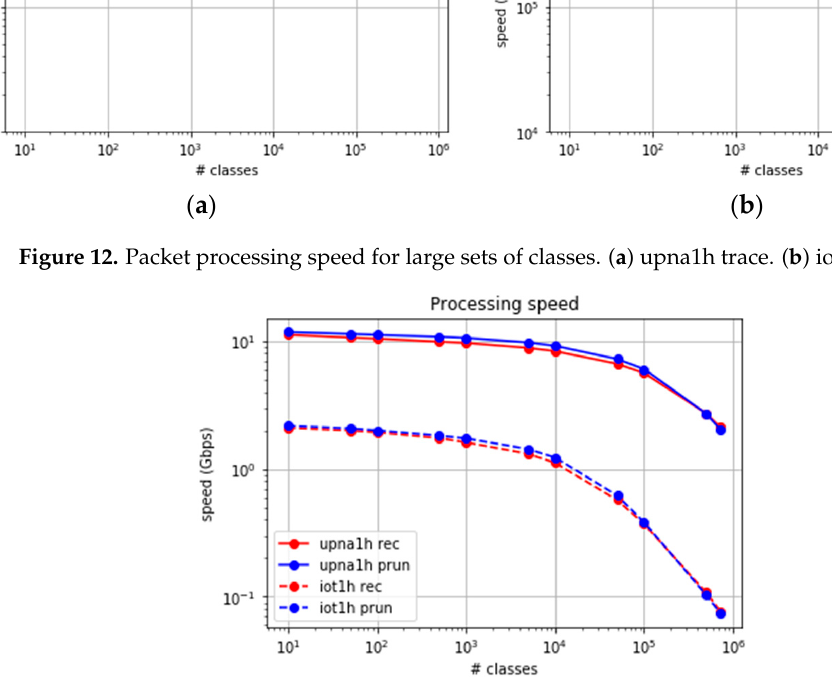
Figure 13. Processing speed in bits per second comparison for upna1h and iot1h traces.